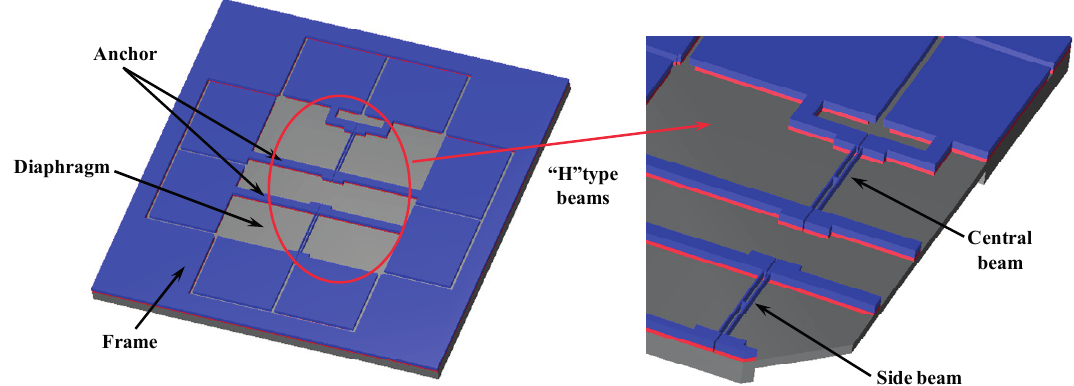
Figure 2. The schematic diagrams of the differential pressure sensor fabricated on a SOI wafer include a pressure-sensitive silicon square diaphragm and two “H” type doubly-clamped resonant beams. Pressure under measurement causes a deflection of the diaphragm, which is translated to an axial tensile stress in the central beam and an axial compressive stress in the side beam, leading to resonant frequency shifts towards opposite directions enabling a differential